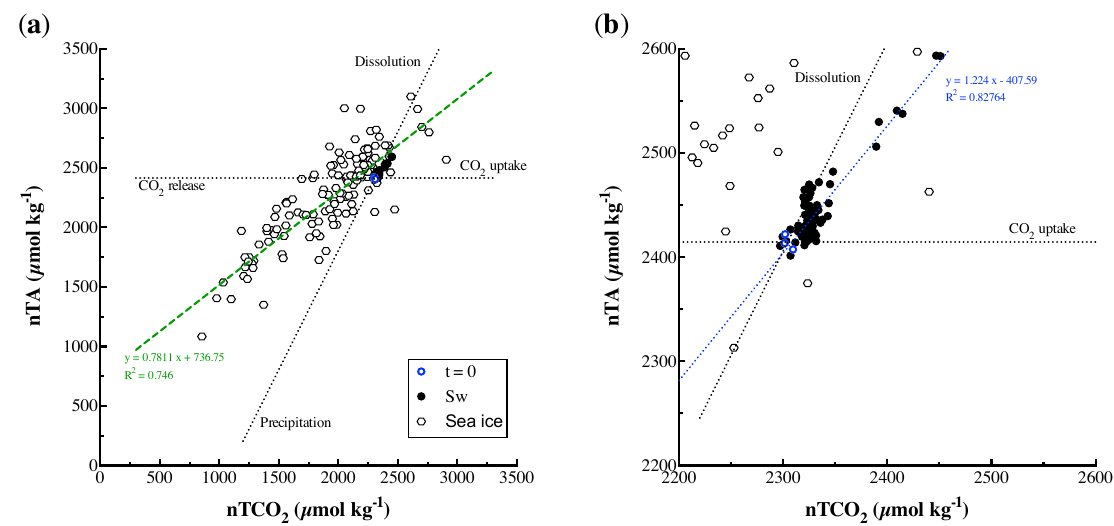
Figure 6. (a) Relationship between nTCO 2 and nTA (µmolkg − 1 ) in bulk sea ice (white hexagons) and seawater (black dots). (b) Zoomed-in image of seawater data. The different dotted lines represent the theoretical evolution of nTA and nTCO 2 ratio following the precipita- tion/dissolution of calcium carbonate and release/uptake of CO 2 ( g ) . A linear regression is shown in green for the ice samples (a) and blue for the seawater samples (b)